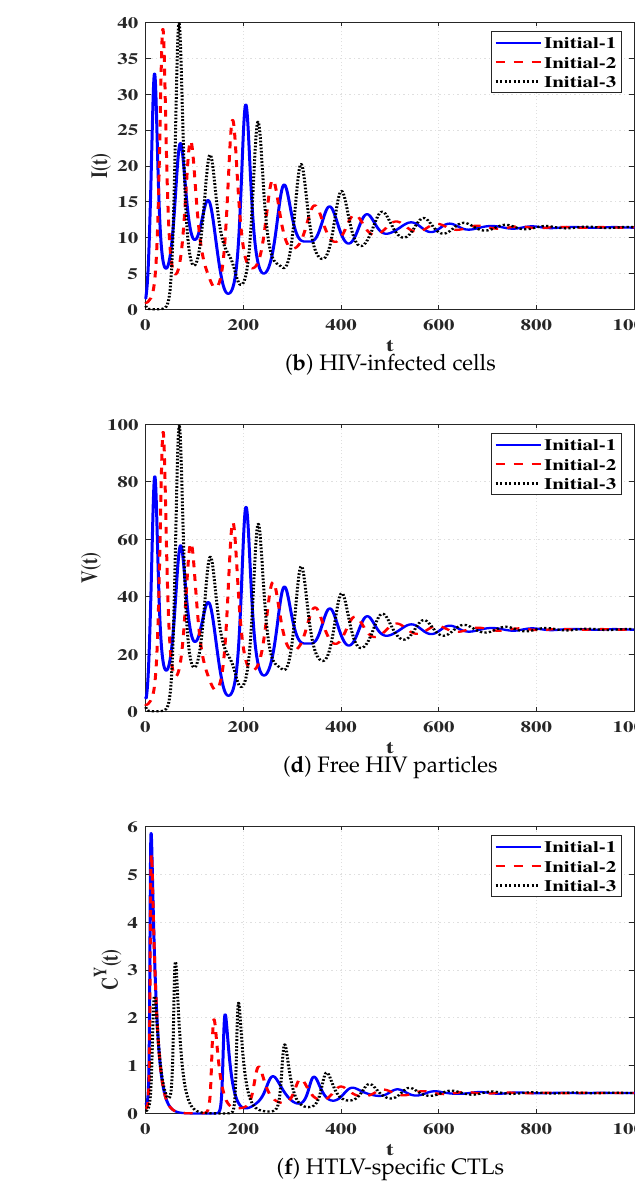
Figure 8. Solutions of system (4) when (cid:60) 6 > 1, (cid:60) 7 ≤ 1, and (cid:60) 2 / (cid:60) 1 >